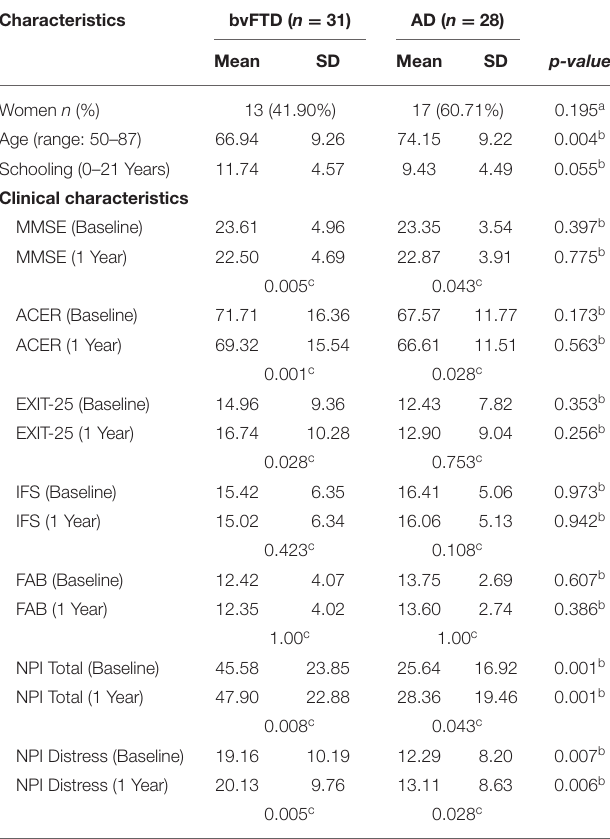
TABLE 1 | Demographic and clinical characteristics of patients diagnosed with Alzheimer’s disease (AD) and behavioral variant frontotemporal dementia (bvFTD).